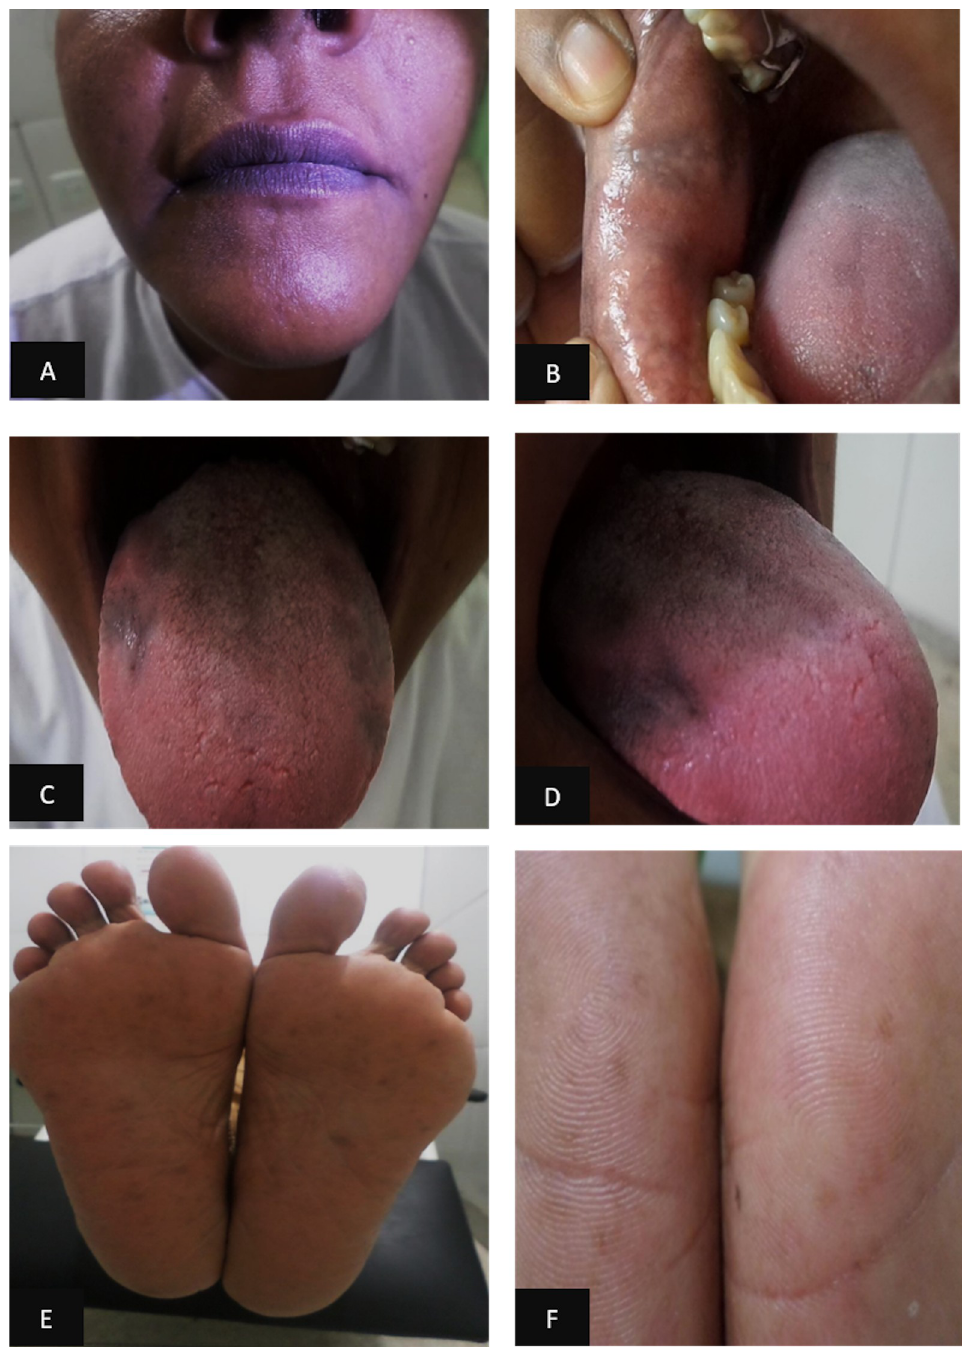
Fig 2. Clinical manifestations of skin hyperchromia due to the side effect of clofazimine. (a) Hyperpigmentation of the lip region; (b) internal mucosa of the mouth (cheek); (c) and (d) tongue; (e) plantar, and (f) hypothenar regions. enanthematous gray lesions mainly on palms and soles and on the lips, internal mucosa of the mouth (cheek) and tongue (Fig 2). In addition, she reported intense headache, epigastralgia, and change in taste, side effects due to clofazimine. The medication was discontinued and